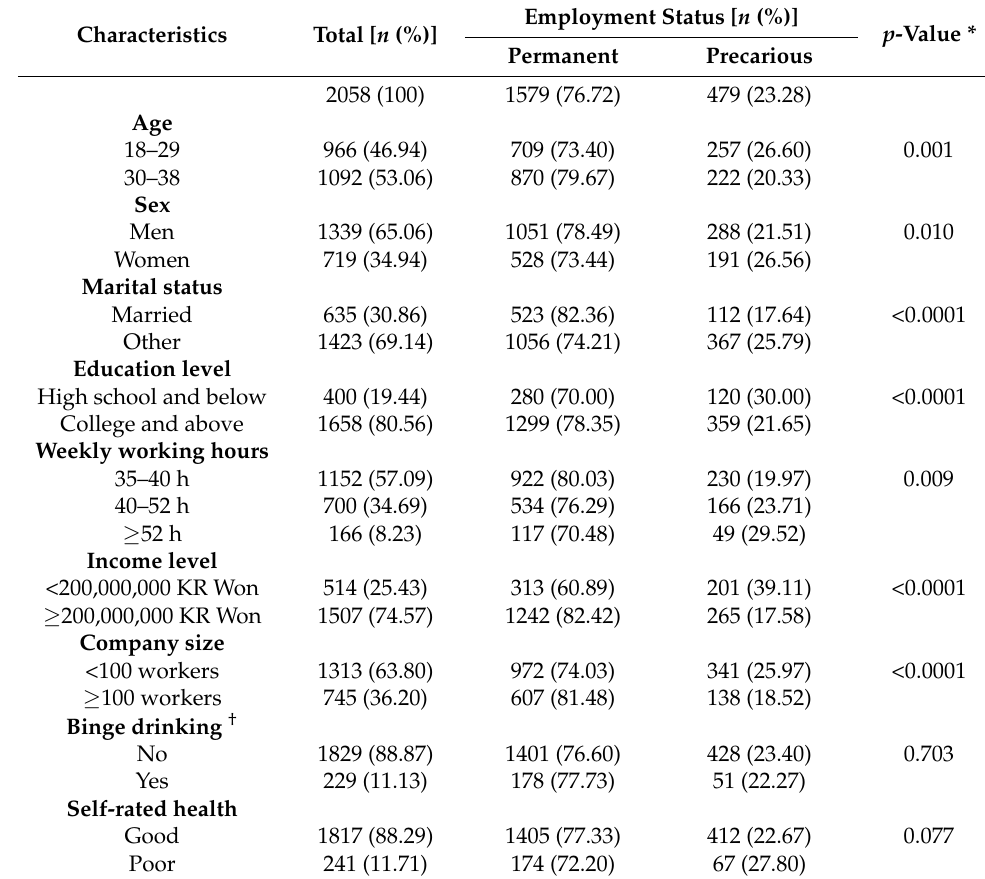
Table 2. Logistic regression models for CAGE as a screen for alcohol-use disorders according to PE.